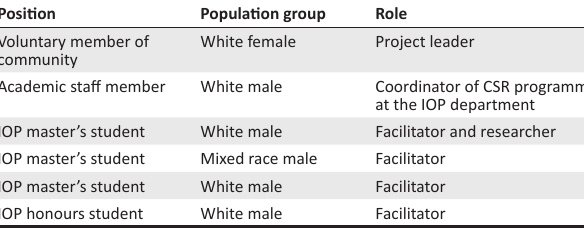
TABLE 1: Biographical information of participants ( n = 6).